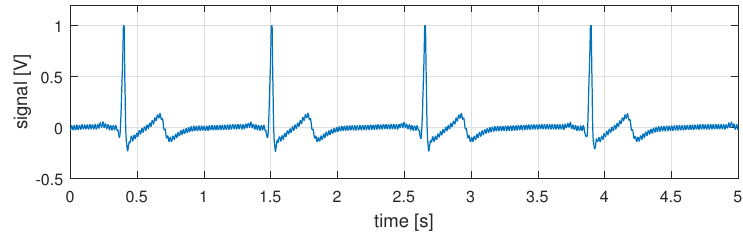
Figure 5. Five seconds of gathered sensor data after processing on our sensor board. Visible are the ECG characteristics, but also some residing high frequency artifacts.